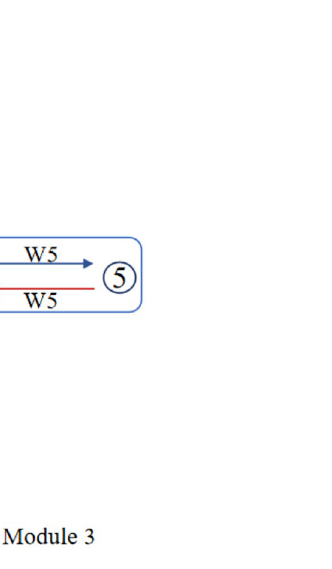
Fig 2. An example of weight delay between two forward